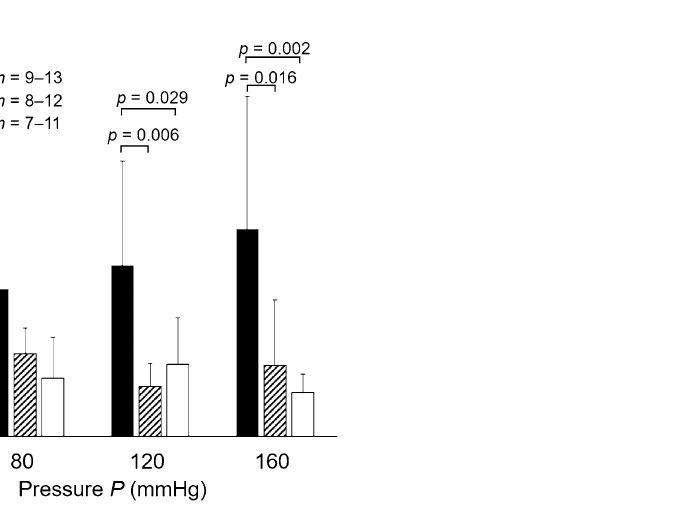
Figure 8. Comparison of flow velocity v between SML1–SML3. N , Number of mice; n , Number of data. Data were tested using the Steel–Dwass test. The graph was created using the Microsoft Excel for Microsoft 365